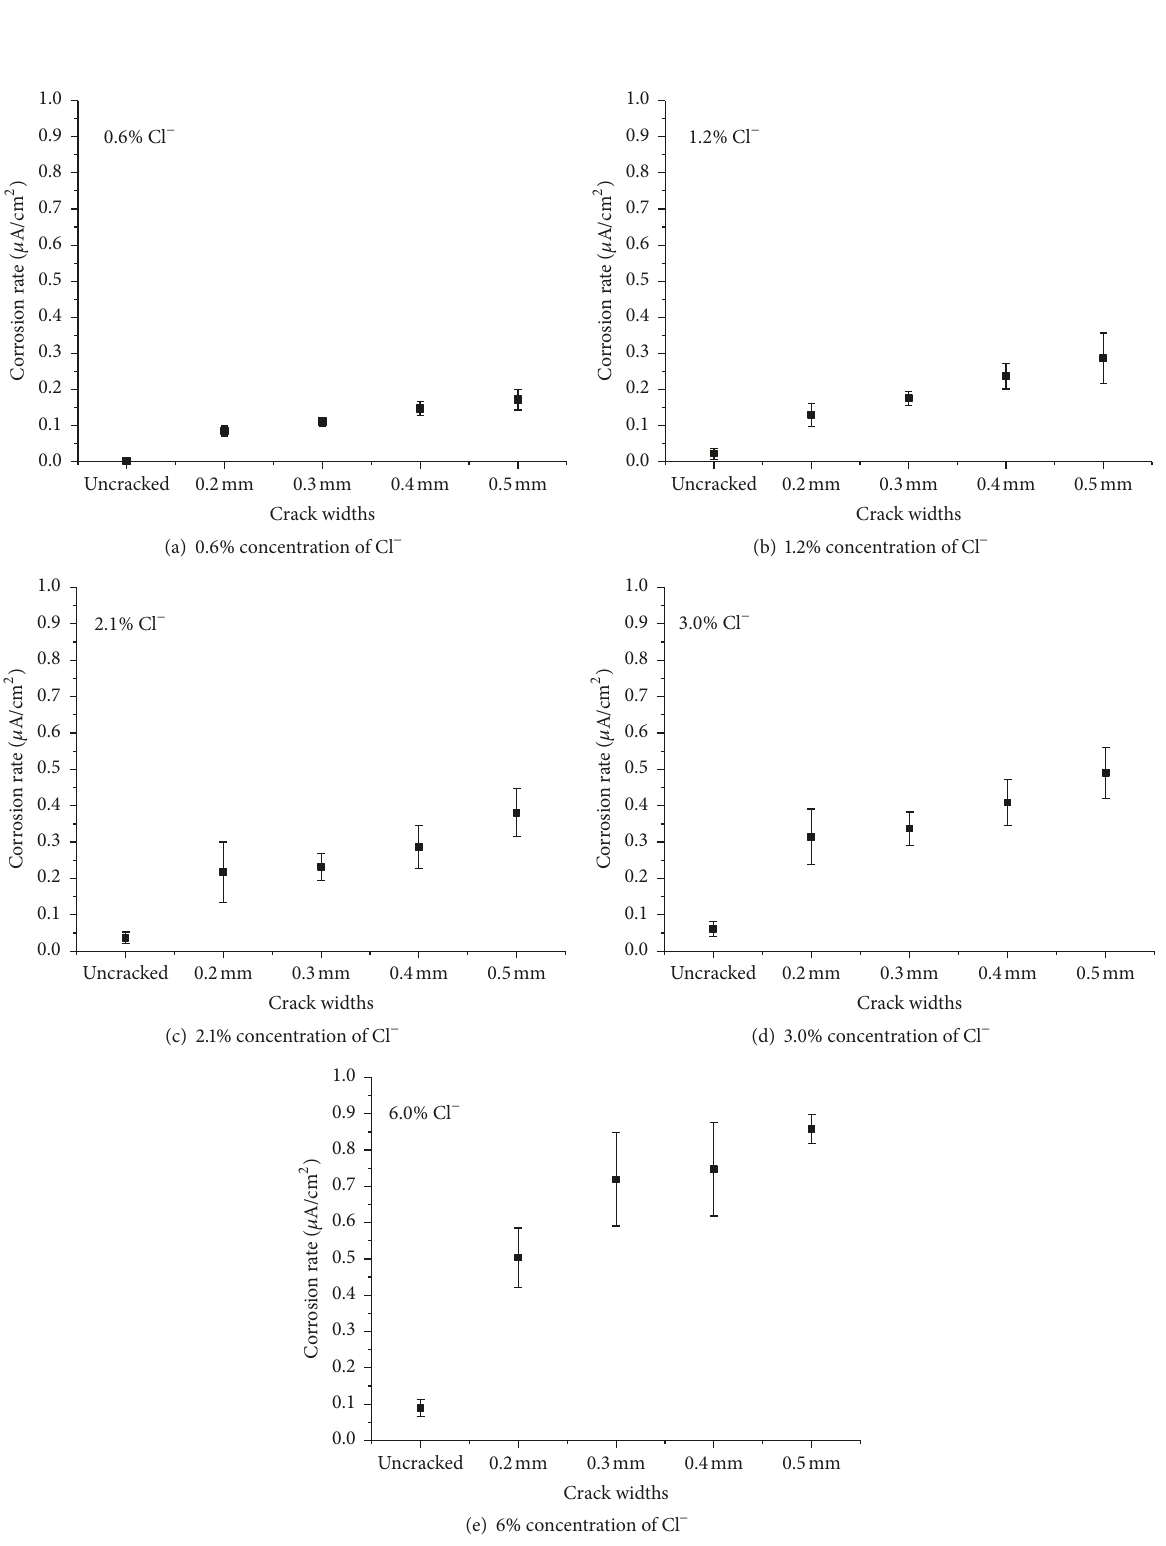
Figure 5: Average corrosion rates in